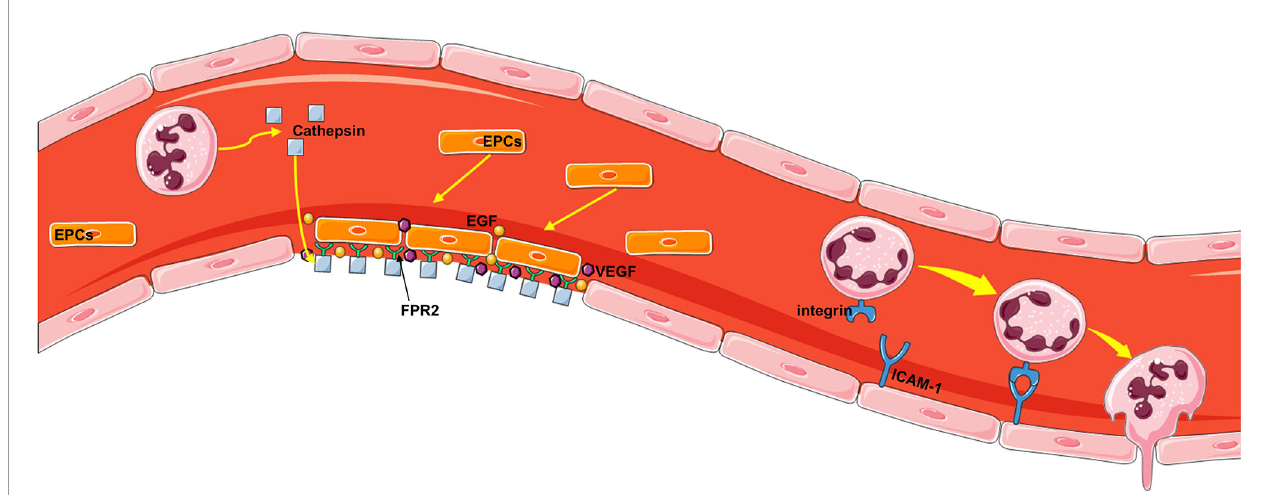
FIGURE 5 | The mechanism by which neutrophils repair the vascular endothelium. First, activated neutrophils deposit the antimicrobial peptide cathelicidin, which promotes the adhesion of circulating endothelial progenitor cells through FPR2, at the site of arterial injury. Endothelial progenitor cells recruited in this way can directly cover the injury site but also release angiogenic growth factor in a paracrine manner, thus promoting reendothelialization. Cathelicidin stimulates endothelial progenitor cells to secrete VEGF and EGF, which can promote the repair of damaged endothelial cells. Neutrophils penetrate the vascular endothelium by reacting with endothelial adhesion molecules to reduce blood fl ow velocity in the vasculature, and then neutrophils cross the vascular wall with the help of a series of adhesion molecules, such as P-, E-, and L-selectin; ICAM-1; and integrins (CD11b, a, and